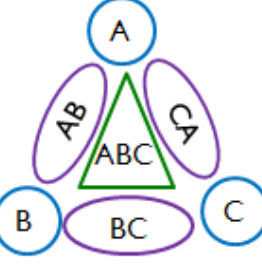
Figure 1. A schematic plot of the normalized data set of mixed odors consists of three odor components: A, B and C. The data points are partitioned into seven component sets according to the contained odor components: A, B, C, AB, BC, CA, and